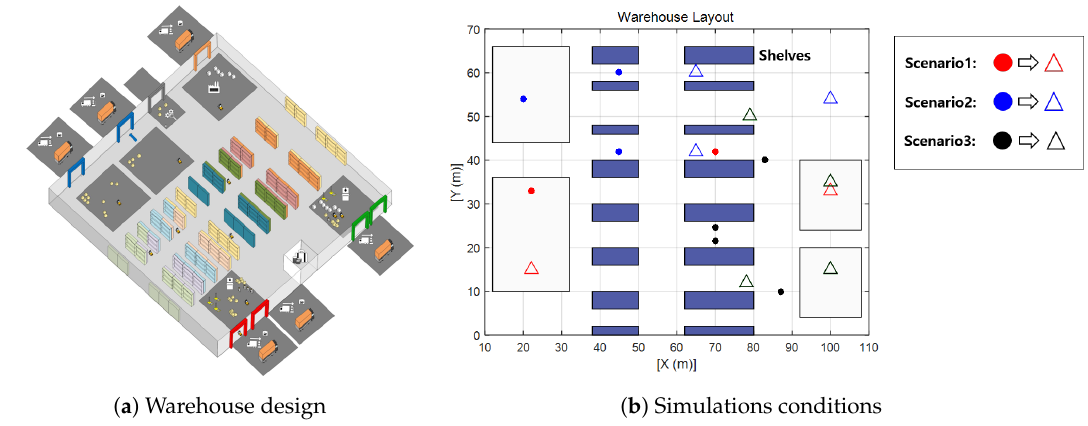
Figure 11. Warehouse design and simulation layout design.